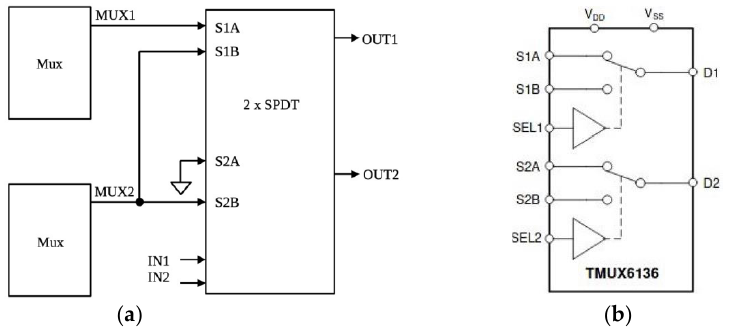
Figure 3. Configuring differential inputs using analog switches ( a ); simplified schematic of TMUX6136 ( b ).